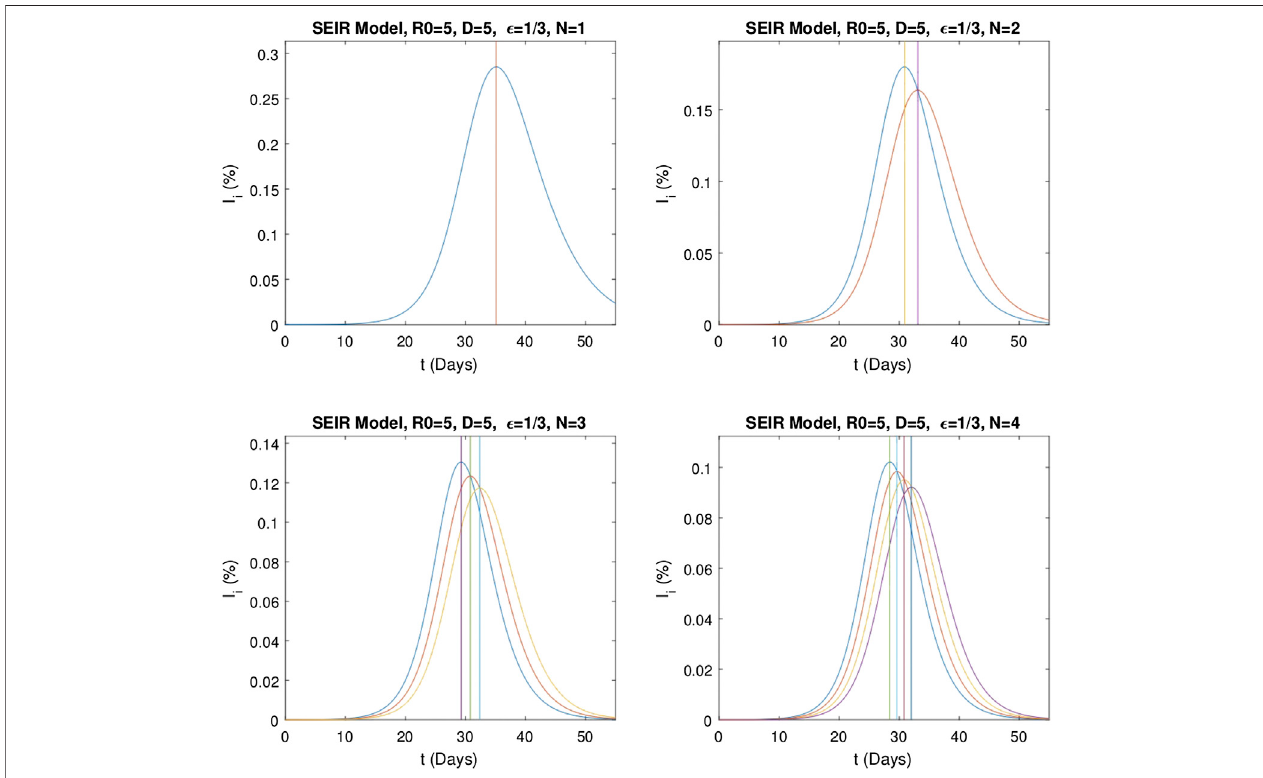
FIGURE 8 | Graphs of the independent infectious stages I 1 , ... I N from numerical solutions of the multistage SEIR model (6). Here, R 0 (cid:2) 2 . 5, ε (cid:2) 1 / 3, and c (cid:2) 0 . 2 × N . In the graphs, vertical lines indicate the position of maximum points of the independent infectious stages. The distance between these vertical lines is approximately 1 / c